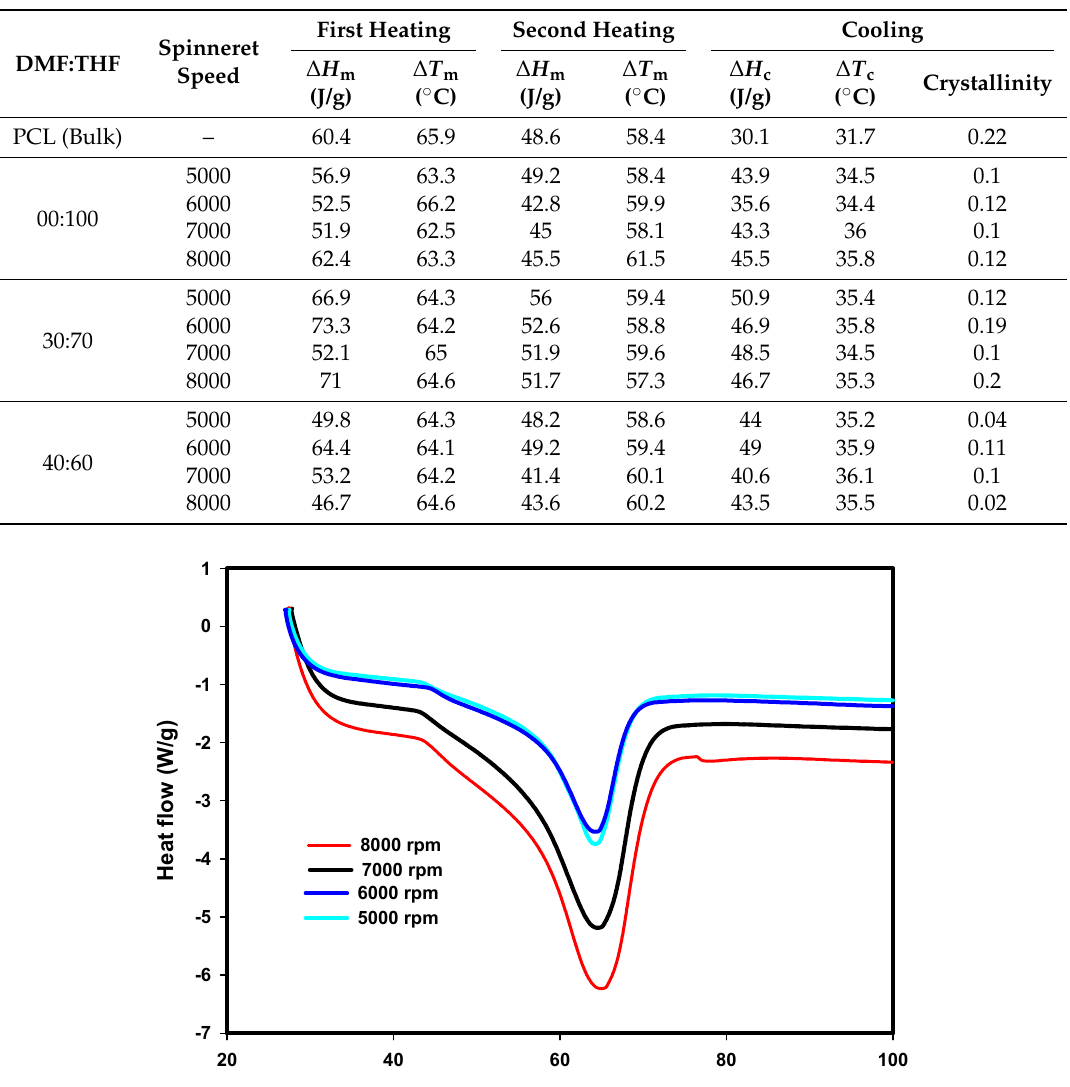
Table 1. DSC results of bulk PCL and fibers prepared by Forcespinning®.